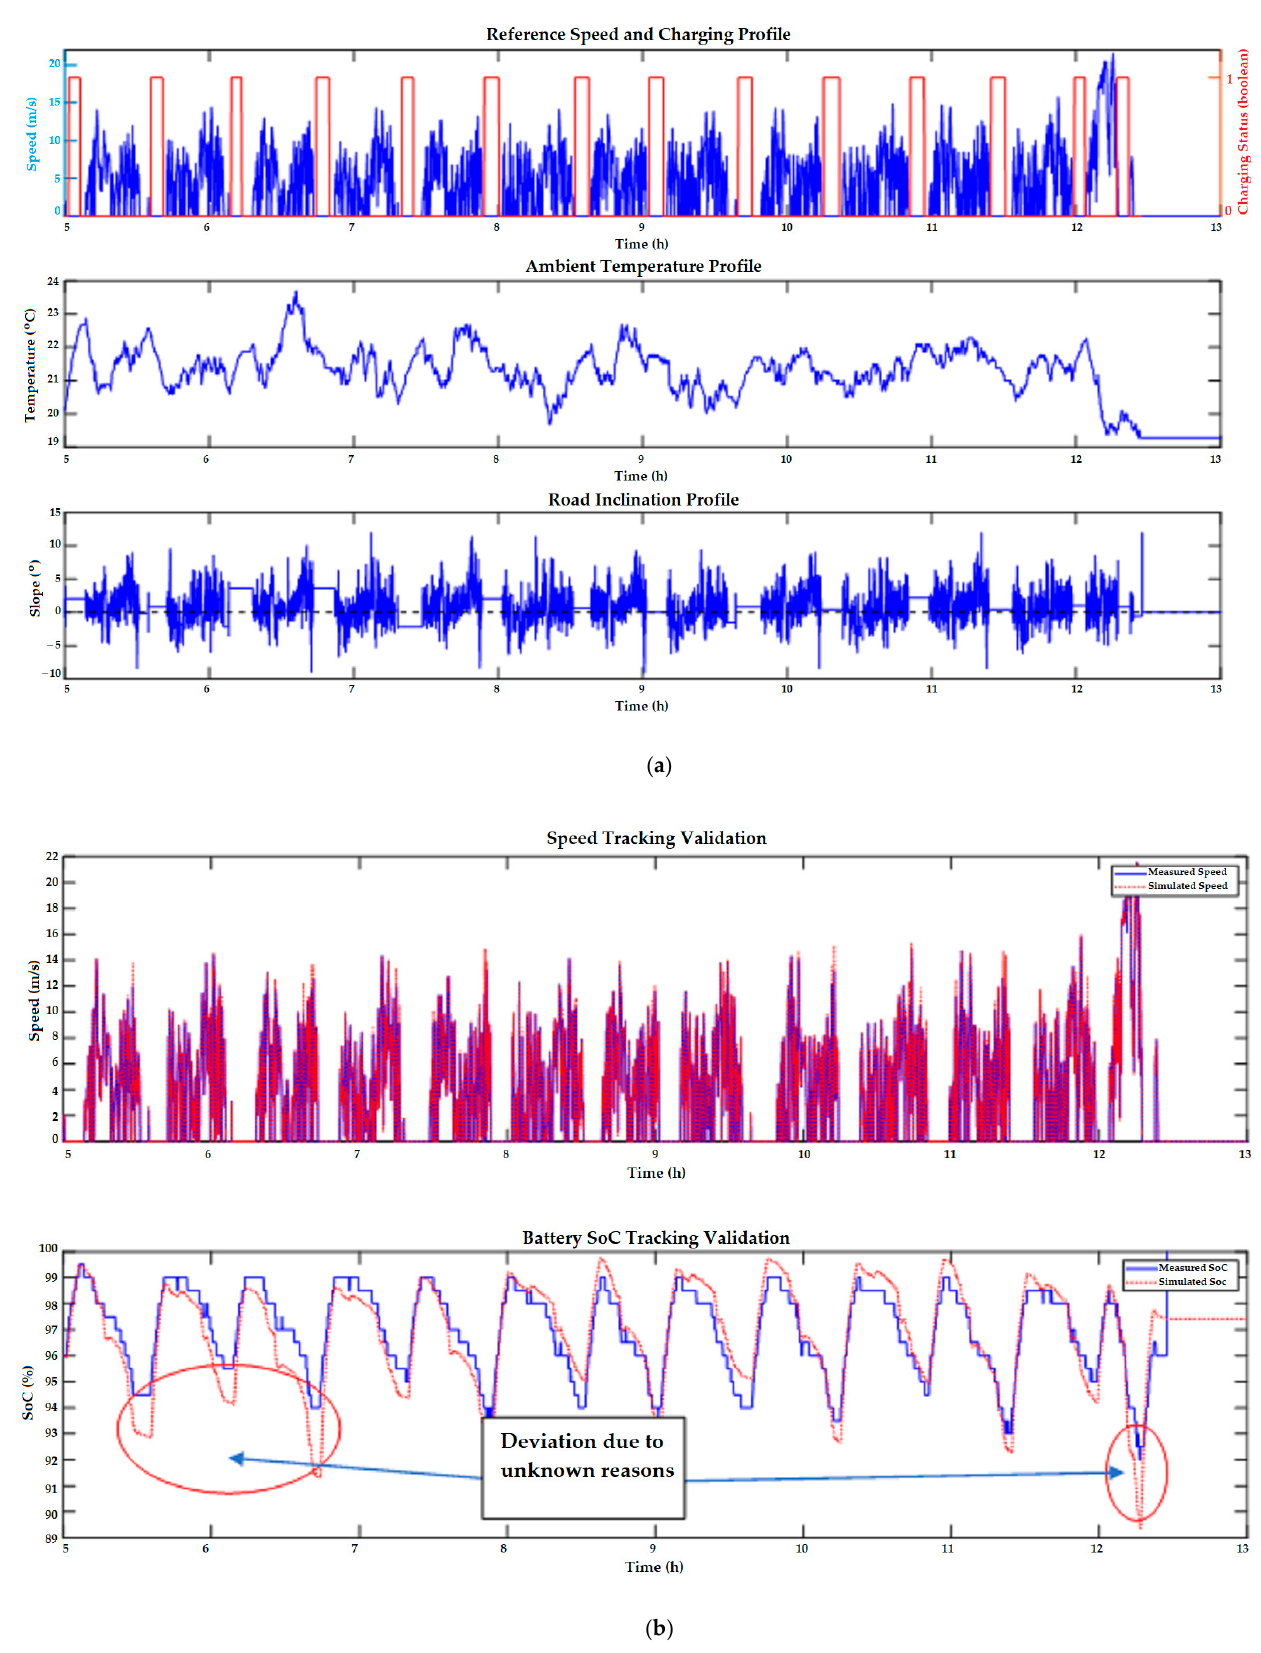
Figure 11. Validation of the May 29th demonstration of 12 m bus in Gothenburg city using the estimates in Table 6. ( a ) Scenario inputs, ( b ) Scenario outputs and